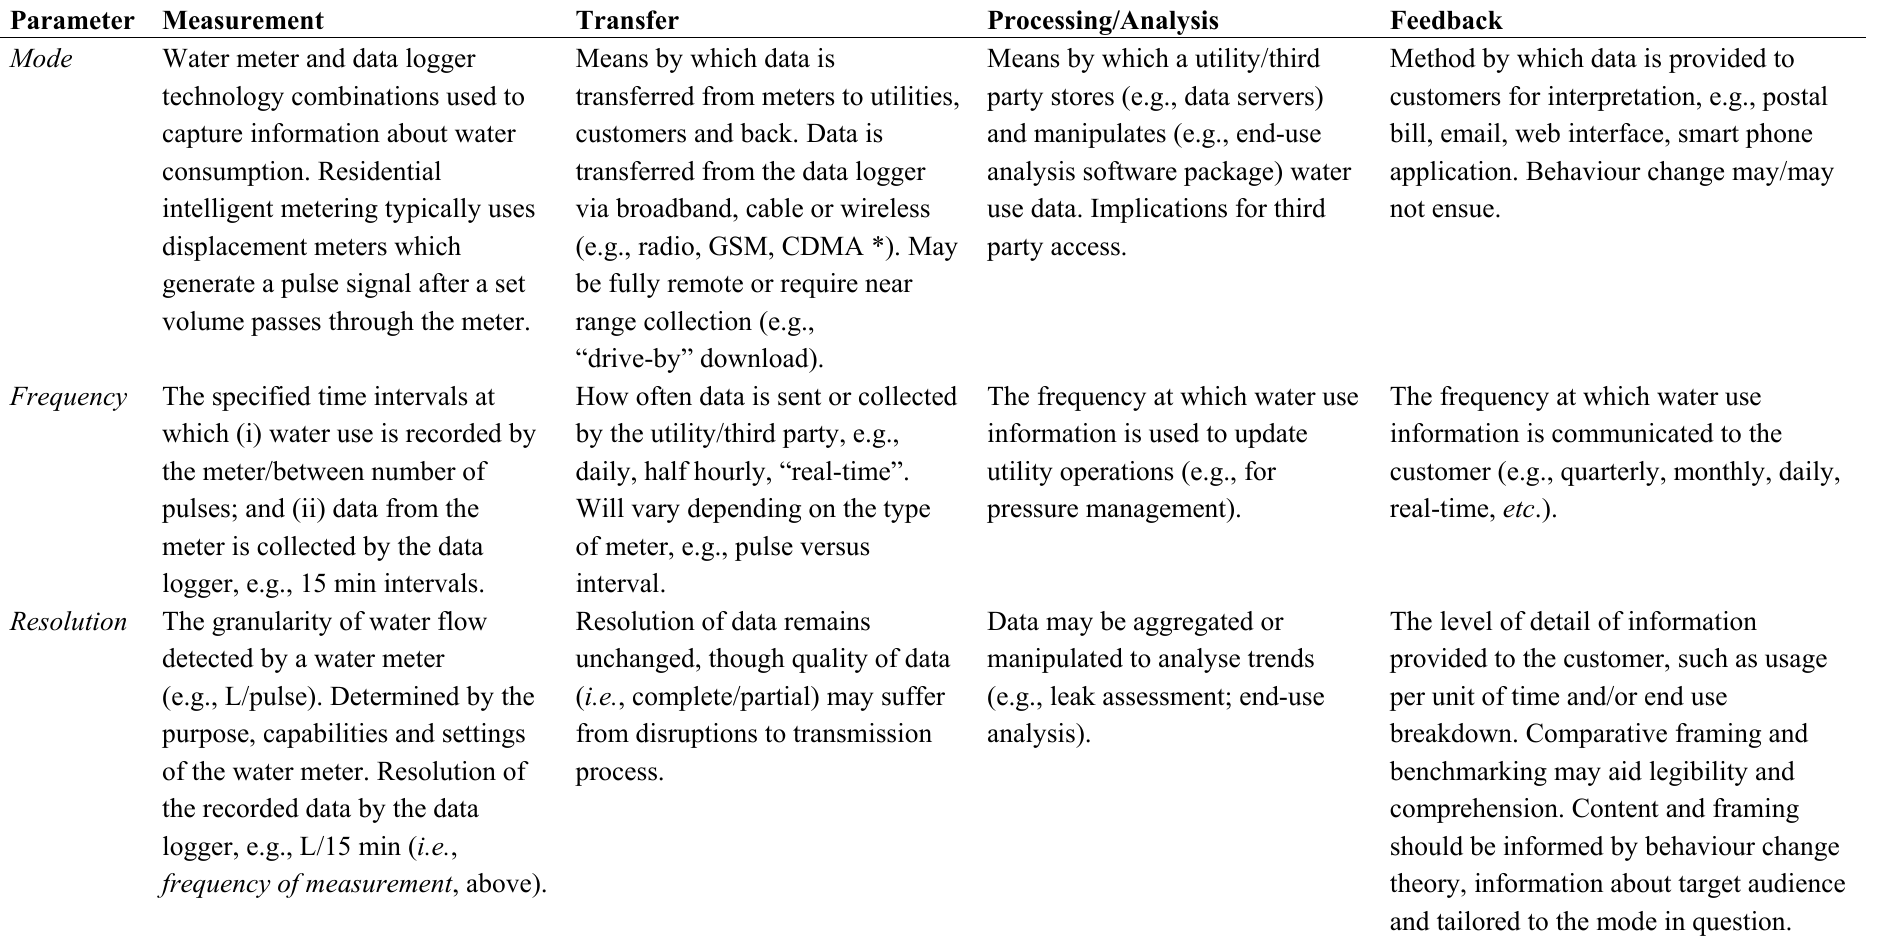
Table 1. Processes of an intelligent metering